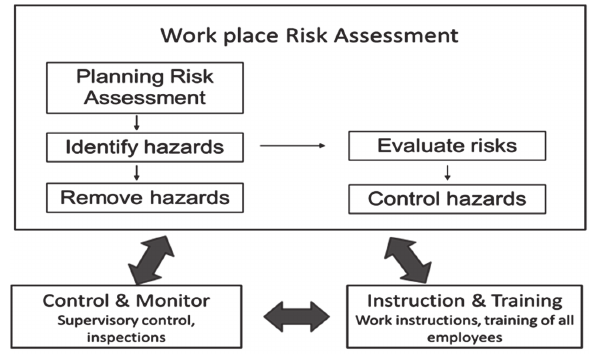
Figure 1. Risk assessment process and related training and monitoring